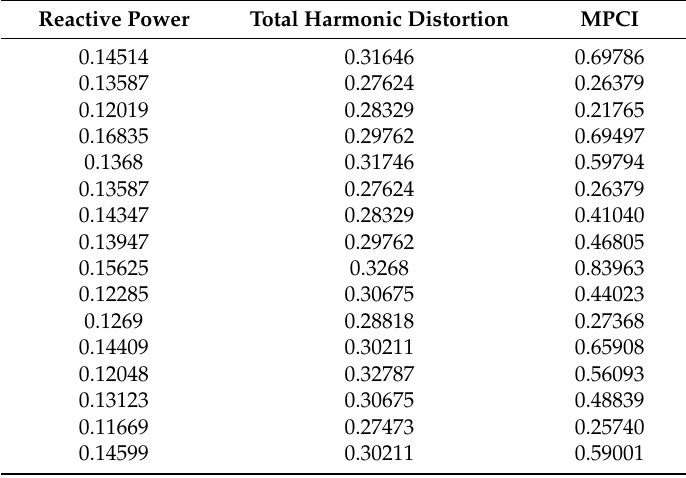
Table 5. MPCI values for the sixteen experimental runs collected from cloud data base.